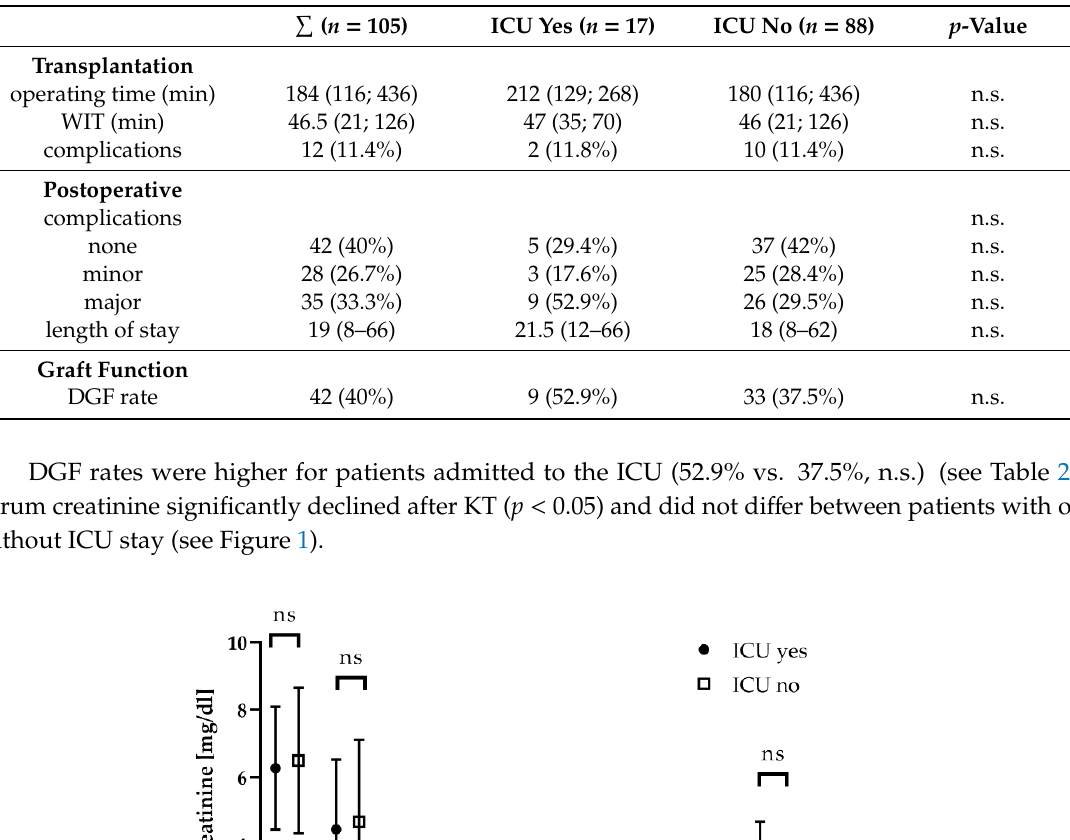
Table 2. Perioperative outcome.